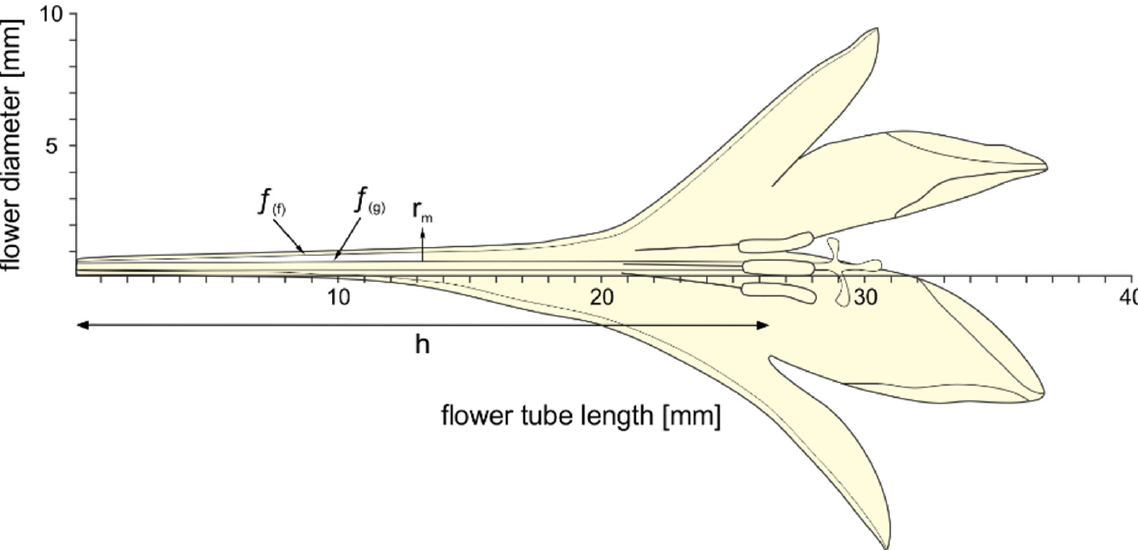
Figure A1. Geometrical model of a Babiana vanzijliae flower, perianth tube length (h) measured up to notches between tepals. The linear functions (f) and (g) are defined by the measured mean inner radius at the base of the tube, mean inner radius at mid-length (r m ), and radius of the stylus (indicated in grey). Rotating the object defined by function (f) around the x -axis creates a frustum of a cone using integral calculus (disc method). The subtraction of the volume of the stylus (function (g)) from the total volume (function (f)) allows the determination of the nectar level inside the perianth tube by using the GeoGebra tool (https://www.geogebra.org/m/se2cwx9s, accessed on 16 April 2021).